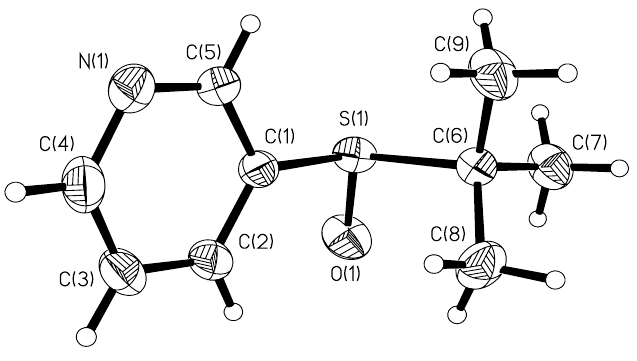
Figure 2. ORTEP atoms labeled and drawn as 30% thermal ellipsoids for compound